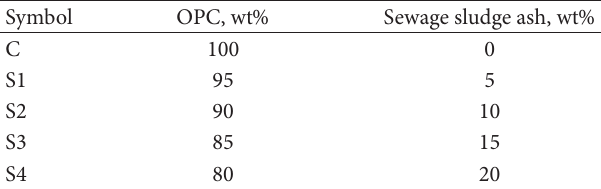
T 1: Mix composition of sewage sludge ash blended cements.